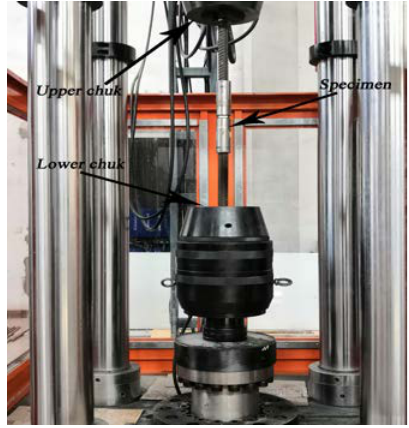
Figure 3. Specimen installation.